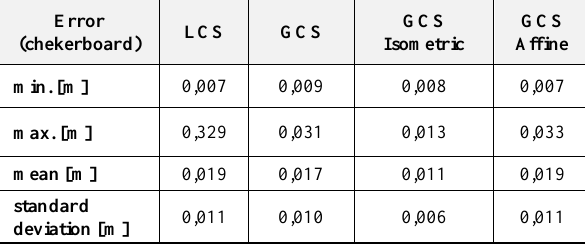
Table 2. Errors of registration using varied reference data Coordinates of reference points were improved by corrections to rare surveying points. It was done by transforming these points from local – primary into global – secondary coordinate